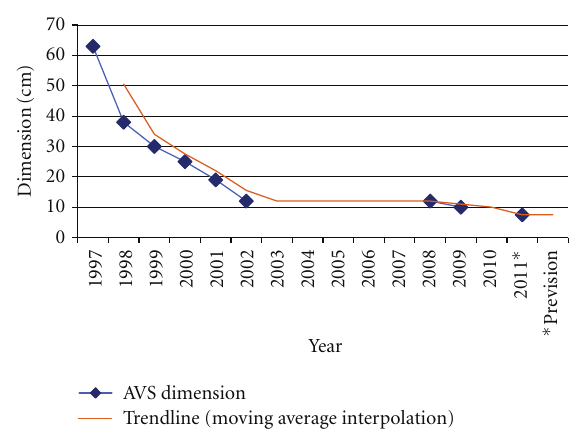
Figure 1: AVS development: dimension reduction; data from 1998– 2002 [4] and 2008-2009 [2].